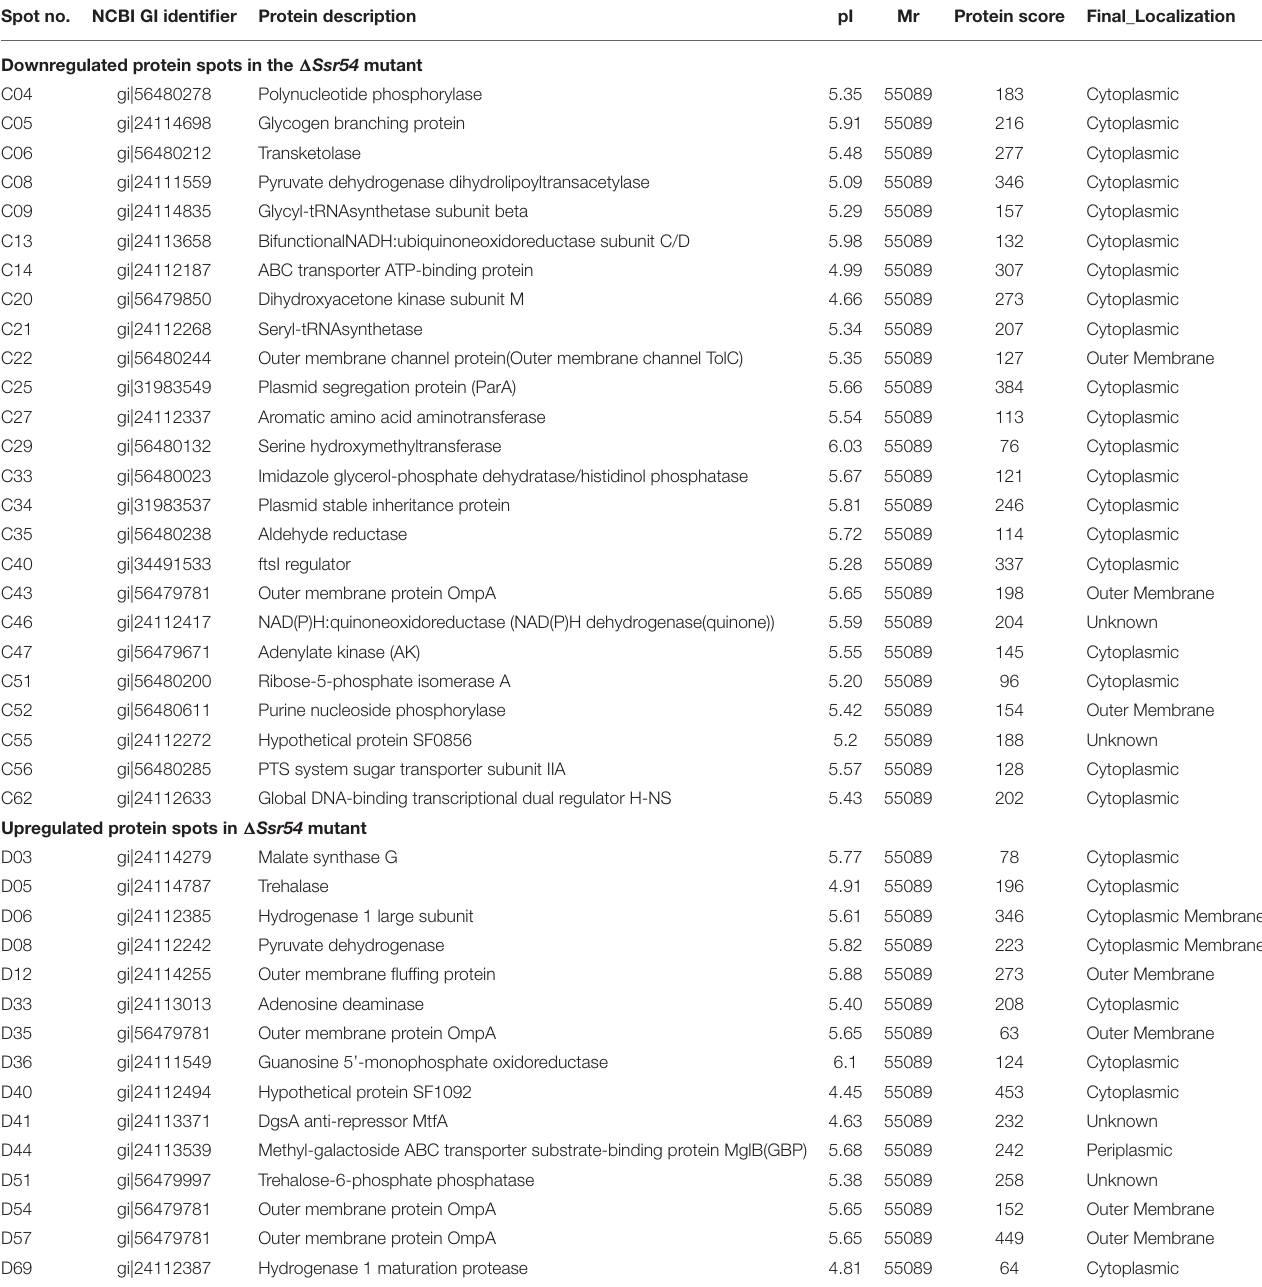
TABLE 2 | Differentially expressed proteins in the small RNA mutant 1 Ssr54 Shigella flexneri . Spot no. NCBI GI identifier Protein description pI Mr Protein score